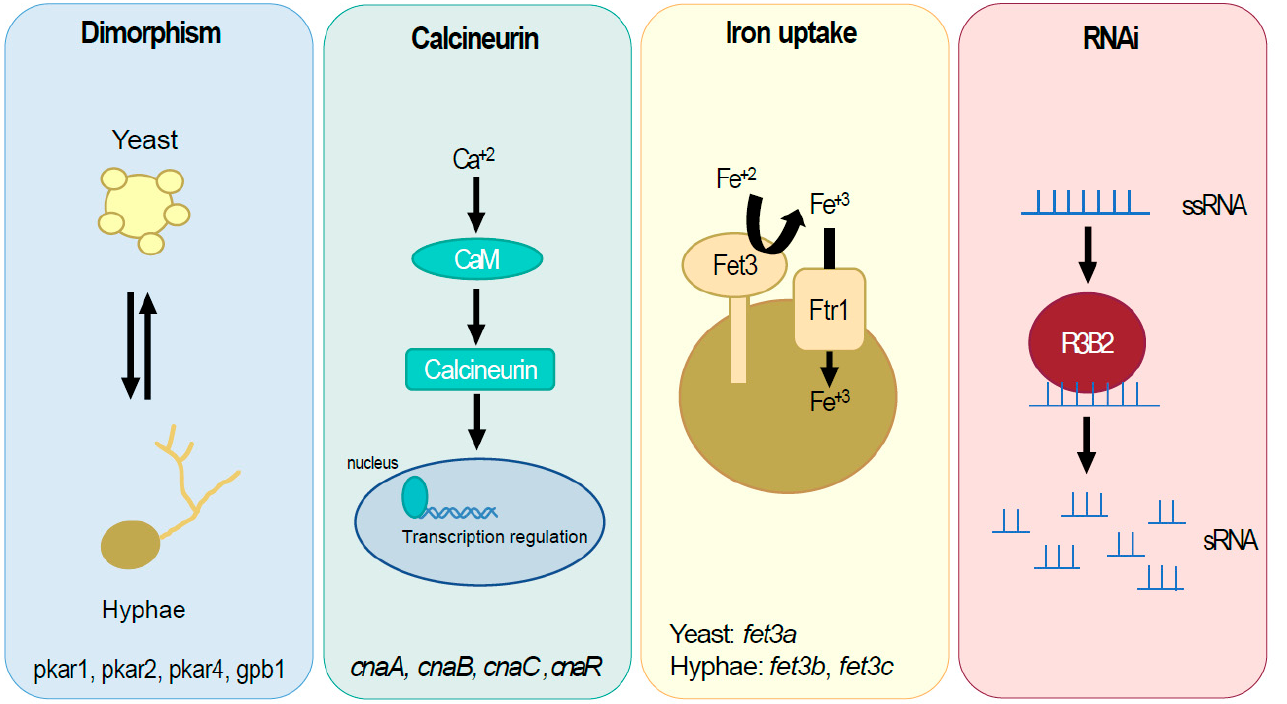
Figure 1. Illustration showing the main pathways and genes that are related to virulence in Mucorales .